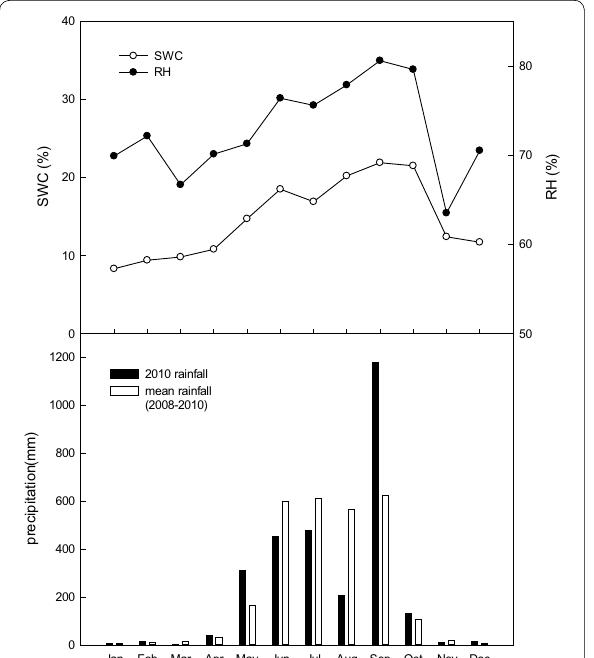
Fig. 1 Monthly changes in soil water content (SWC), relative humid‑ ity (RH), and rainfall in 2010, and the mean rainfall between 2008 and 2010